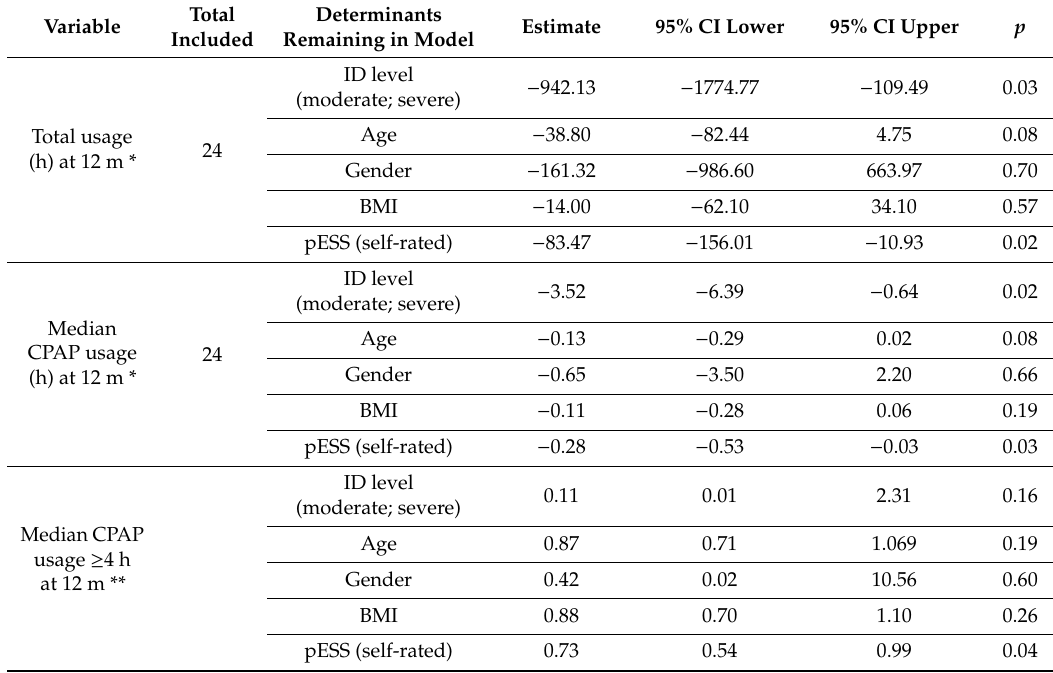
Table A1. Determinants of CPAP usage at 12 m assessed by generalised linear modelling.